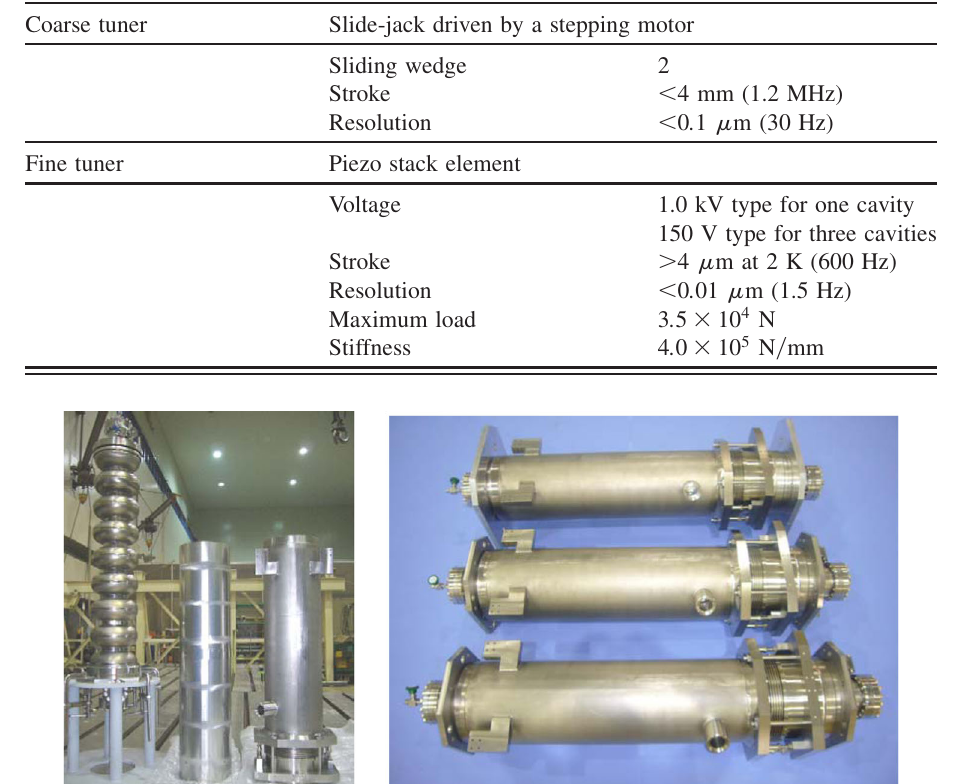
TABLE IV. Main specifications of frequency tuning system.